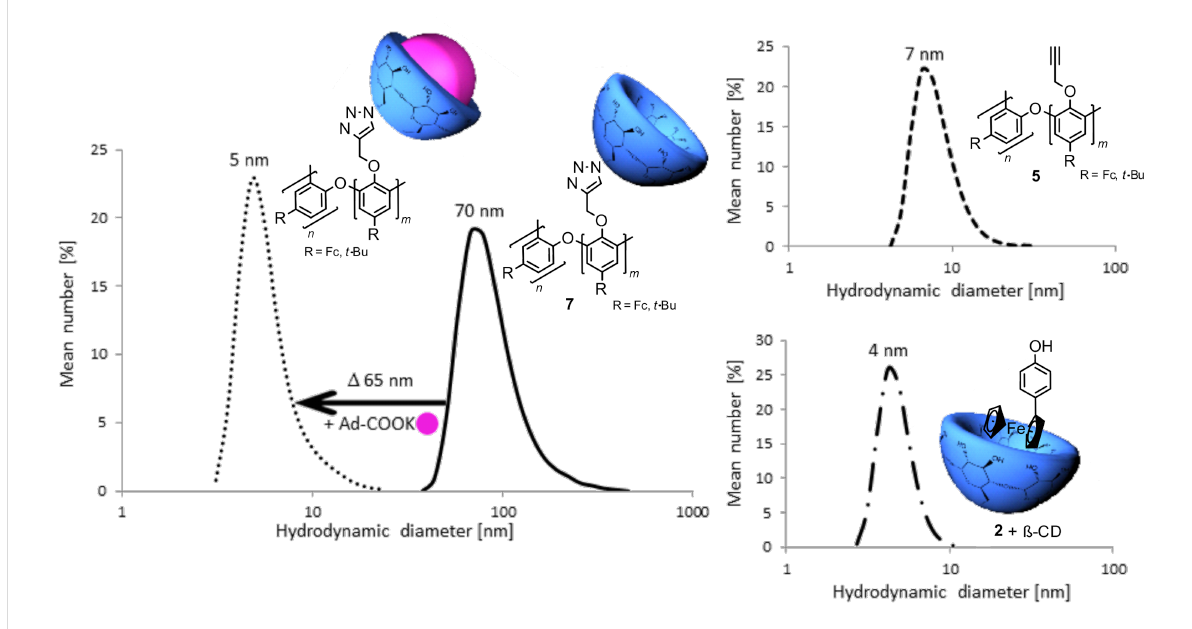
Figure 2: DLS measurement of compound 2 with β -cyclodextrin (— •), alkylated polyphenol 4 (- -), product 7 (—) and its complex with adamantylcar- boxylate (•••).